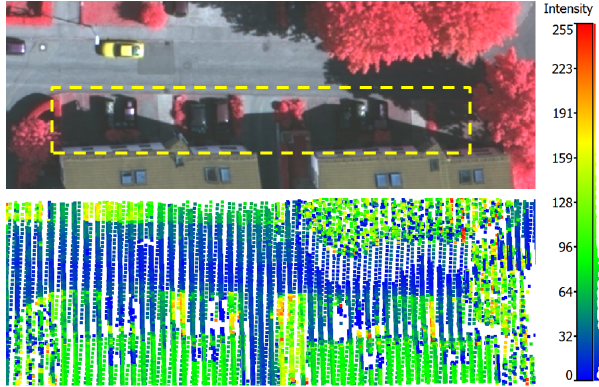
Figure 4. Echo intensity of road and natural soil . The parking spaces are highlighted in the